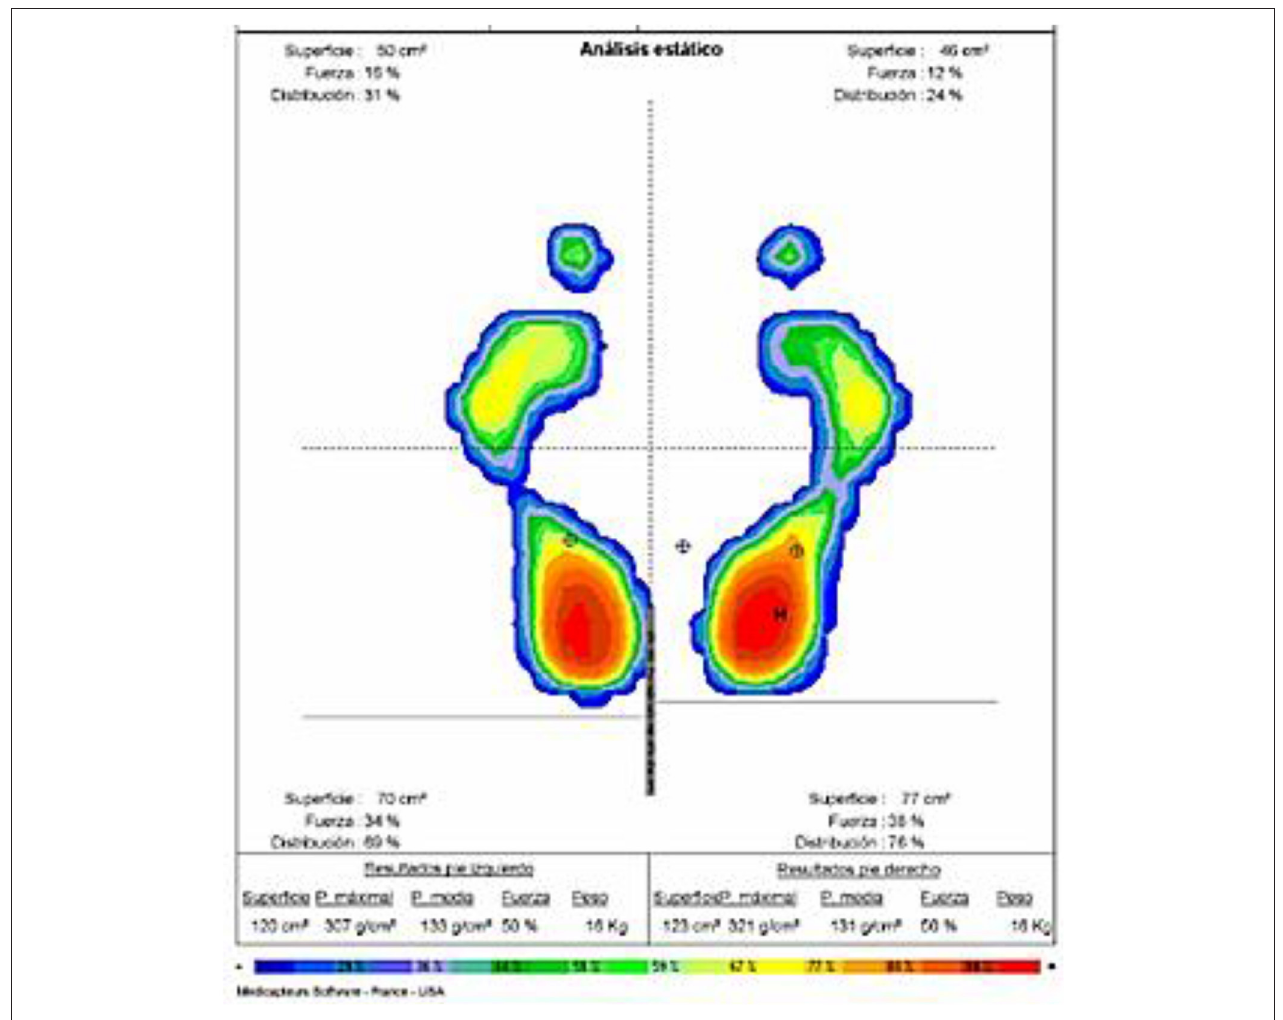
FIGURE 1 | Baropodometric analysis of pressures and center of